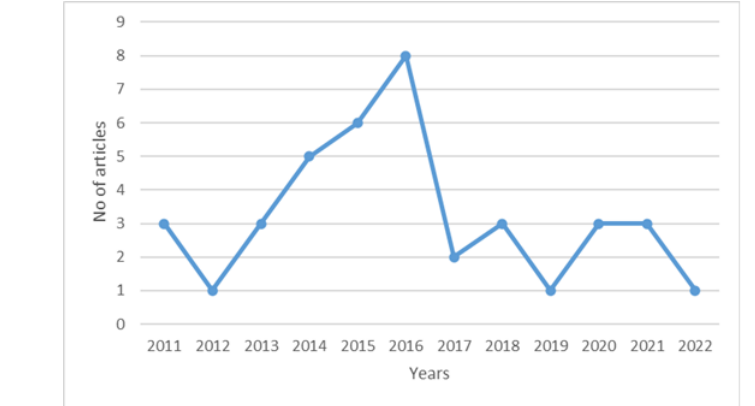
Figure 3 – Publication distribution Рис. 3 – Распространение публикаций Слика 3 – Расподела